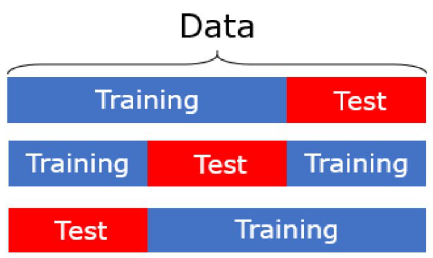
Figure 2. 3-fold